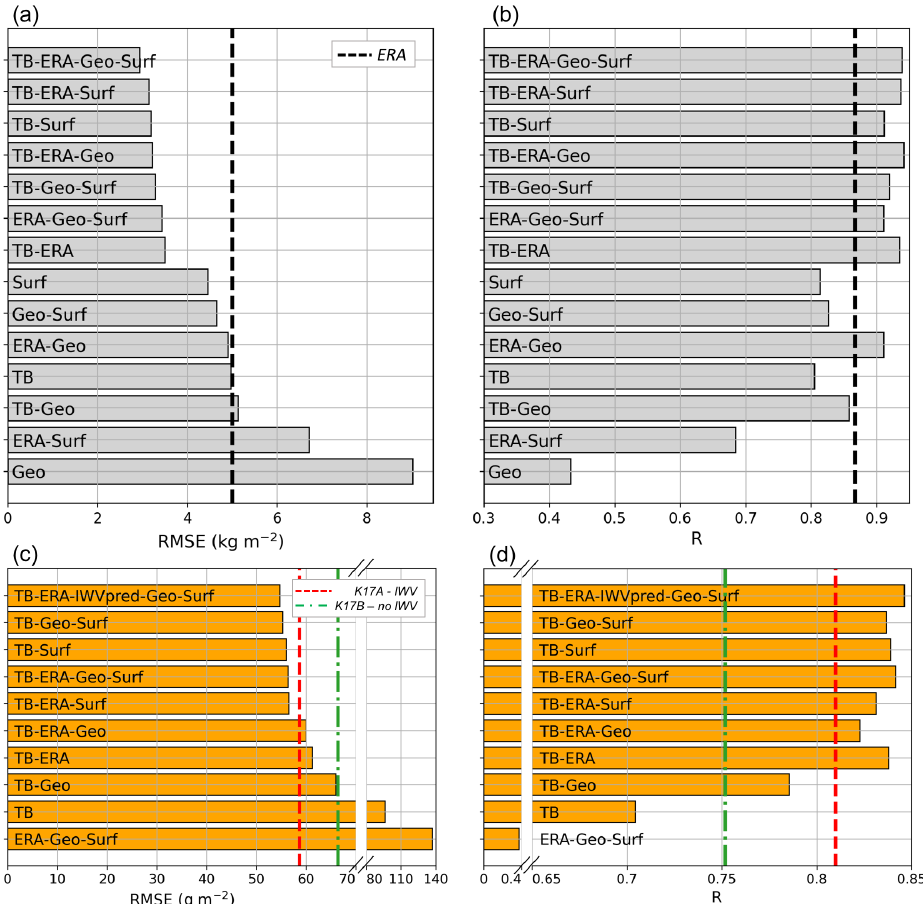
Figure 10. Error of the new retrieval algorithms over Payerne compared to HATPRO retrievals. In panels (a) and (c) the RMSE of IWV and LWP is respectively calculated for different versions of the algorithm. Similarly, R is shown in (b, d) . Each bar shows the result of a version whose input features are specified in the label. In panels (a) and (b) , the black dashed line shows the error of IWV from ERA5 reanalysis data. In (c, d) , the dashed lines present the results from K17A and K17B, as defined in the